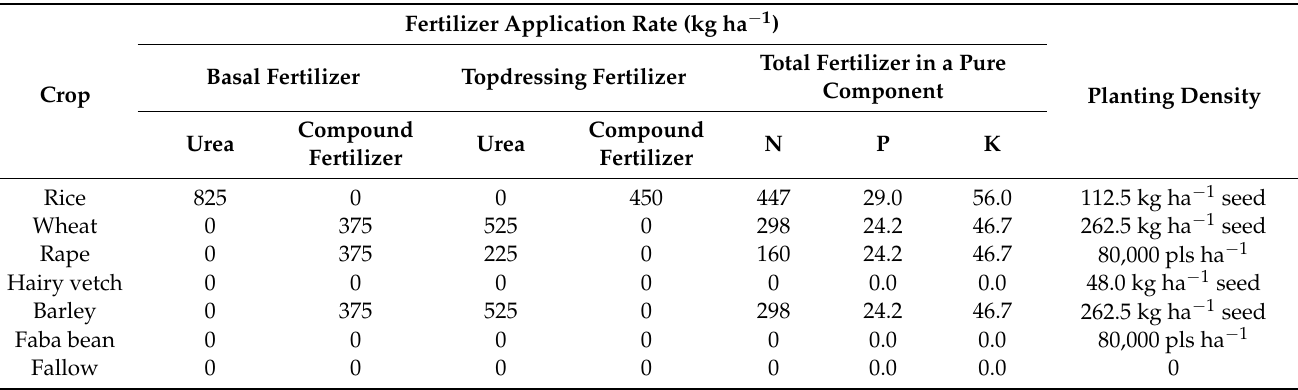
Table 1. The application rate of fertilizer and planting density for each